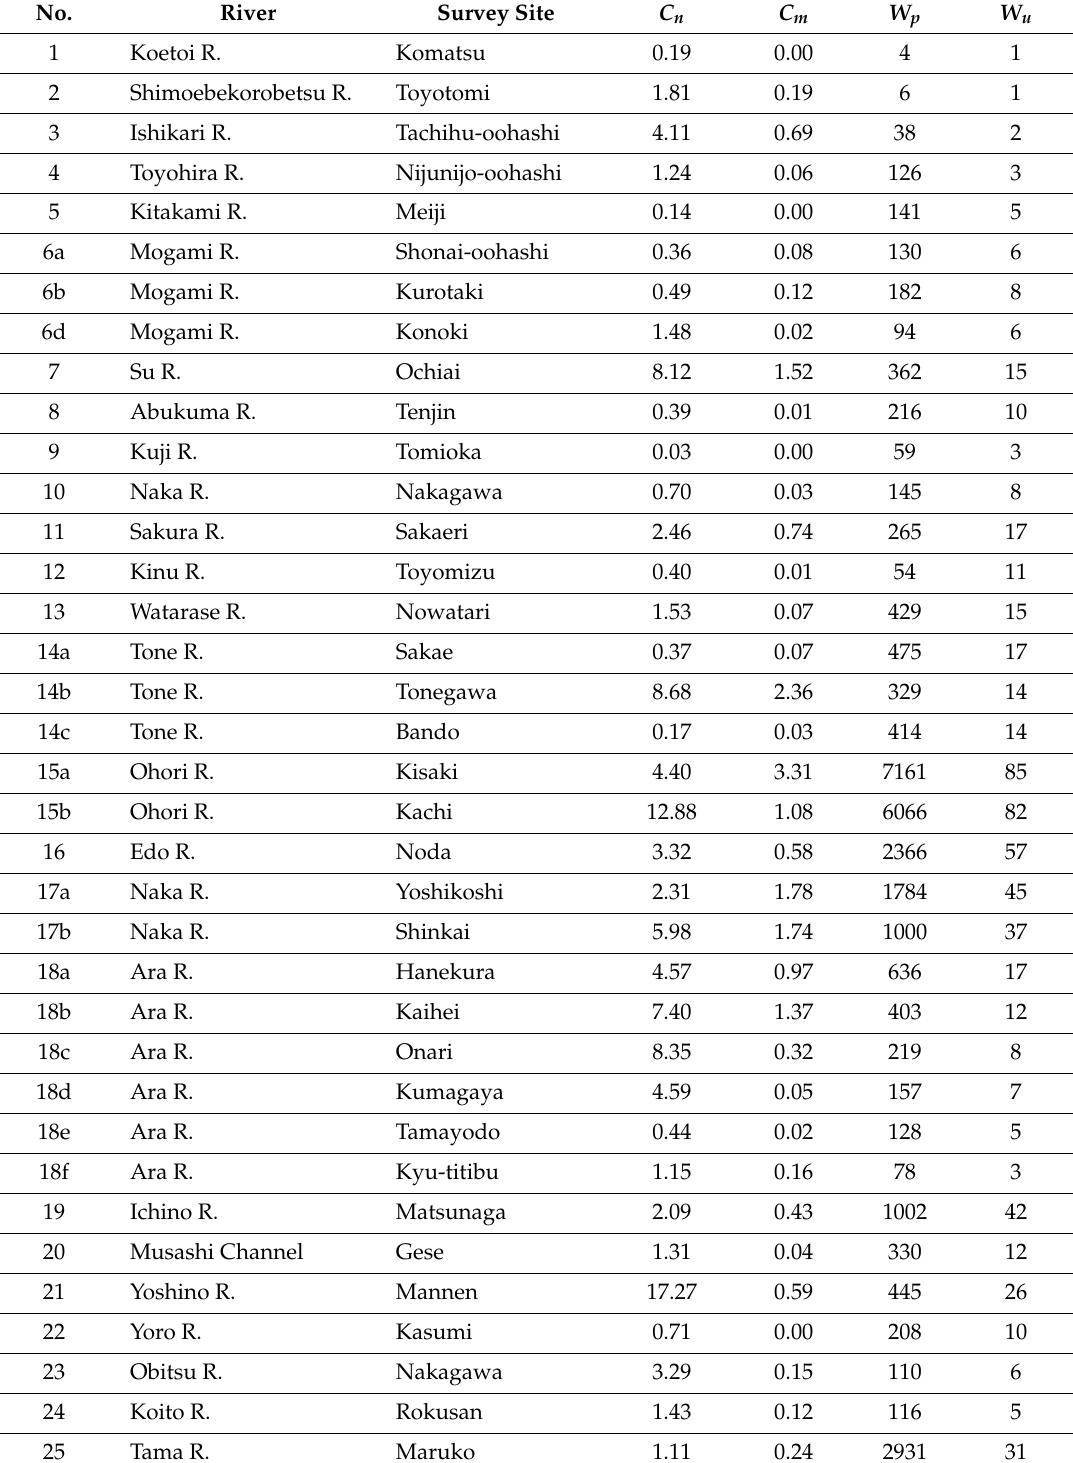
Table A1. MicP numerical concentration C n (particles / m 3 ) and mass concentration C m (mg / m 3 ), and basin characteristics for the 70 rivers and 90 sites used in this study. For the basin characteristics, population density W p (persons / km 2 ) and urban area ratio W u (%) in the upstream area of each observation site are